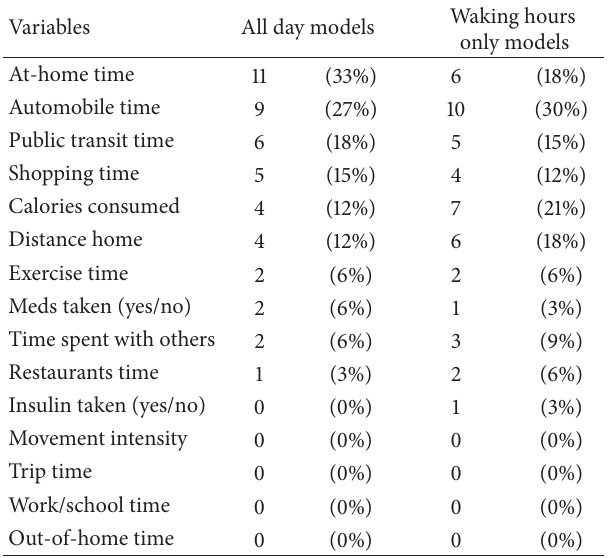
Table 5: Frequency of variable significance in 5-minute ARIMA